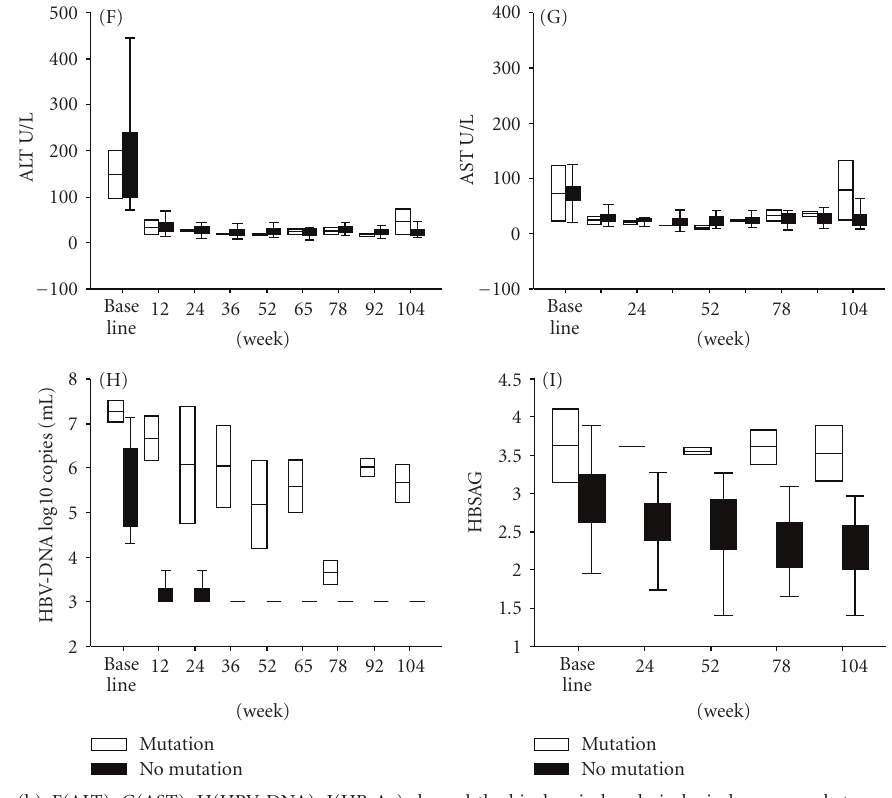
Figure 3: Analysis of Th1/Th2 cytokine producing CD3+CD4+ cells at adefovir dipivoxil treatment week (TW) between mutation and no